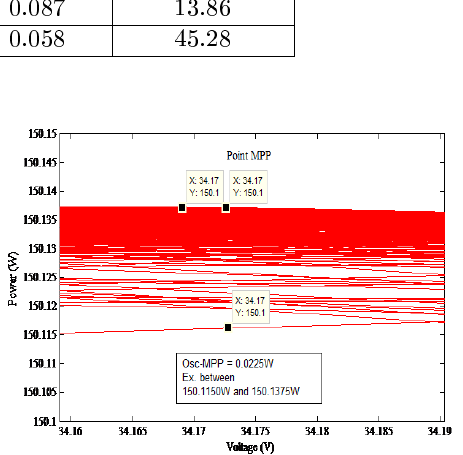
Fig. 16: P-V characteristics: Zoom in Point MPP (os- cillation in the case of the (cid:28)xed step size MPPT).